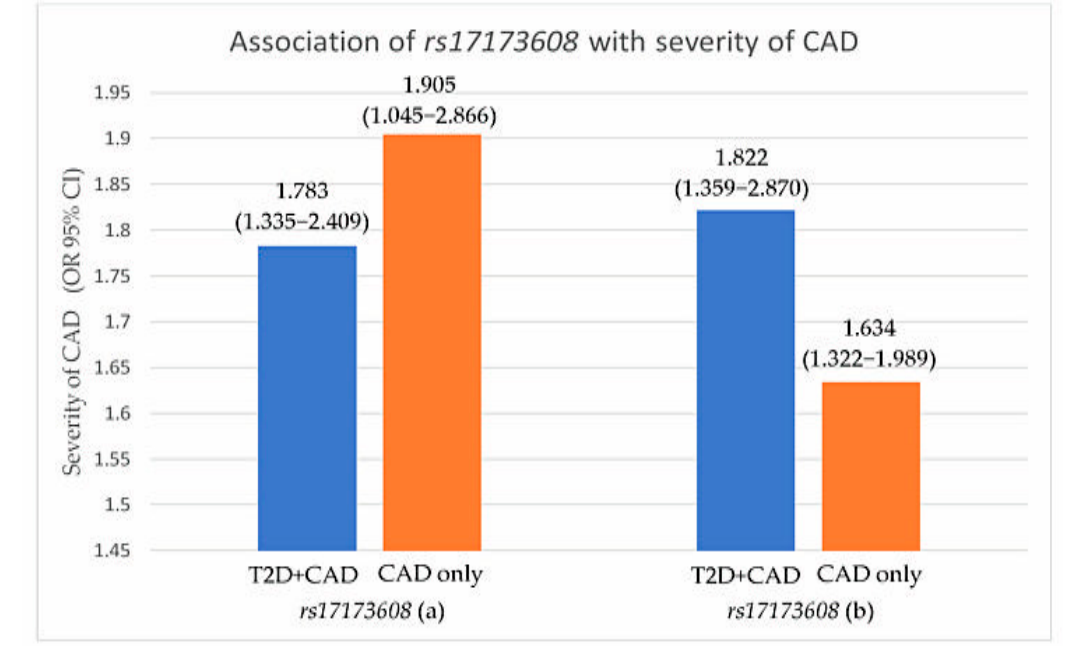
Figure 2. Association of rs17173608 with severity of CAD. ( a ) SVD vs. DVD, ( b ) SVD vs. TVD. OR: odds ratio; CI: confidence interval.